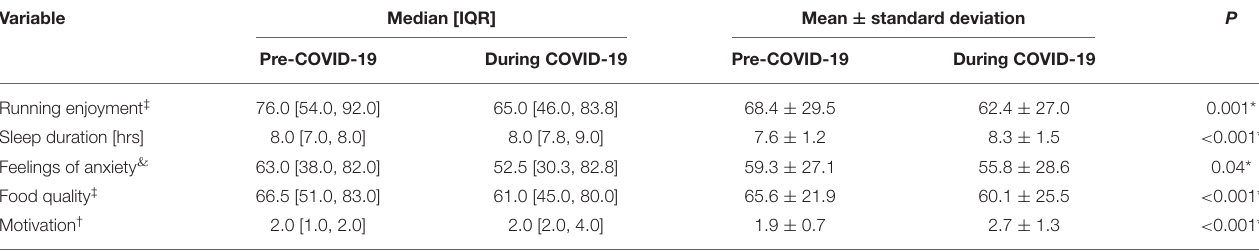
TABLE 1 | Differences in running enjoyment, sleep habits, feelings of anxiety, food quality, and running motivation pre- and during COVID-19 social distancing restrictions. Variable